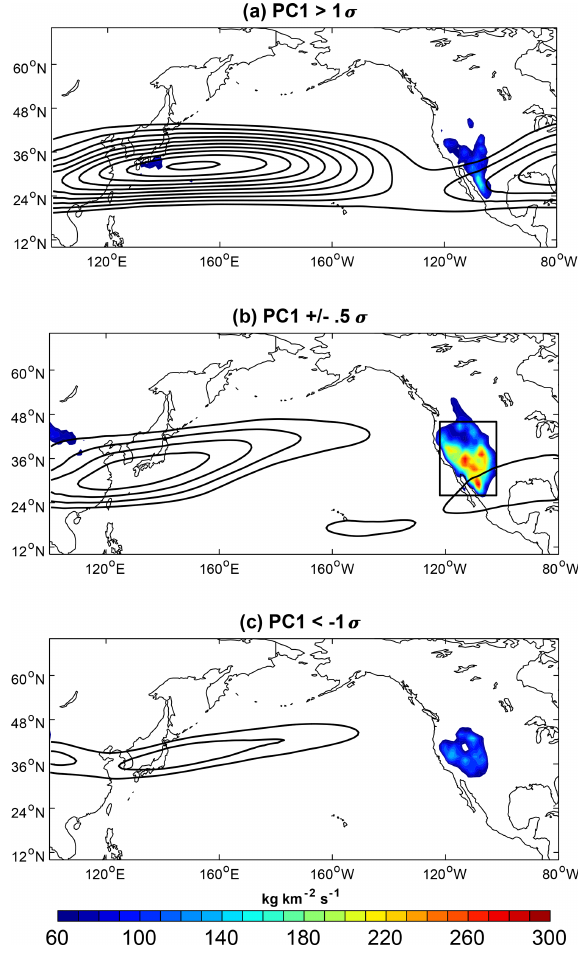
Figure 4. Composite STT-PBL during the three jet phases using ERA-Interim PC1 for 1980–2016. (a) STT-PBL during days charac- terized by a wintertime value ( N = 998); (b) STT-PBL during days characterized by a transitional PC1 value ( N = 952); (c) STT-PBL during days characterized by a summertime PC1 value ( N = 1125).